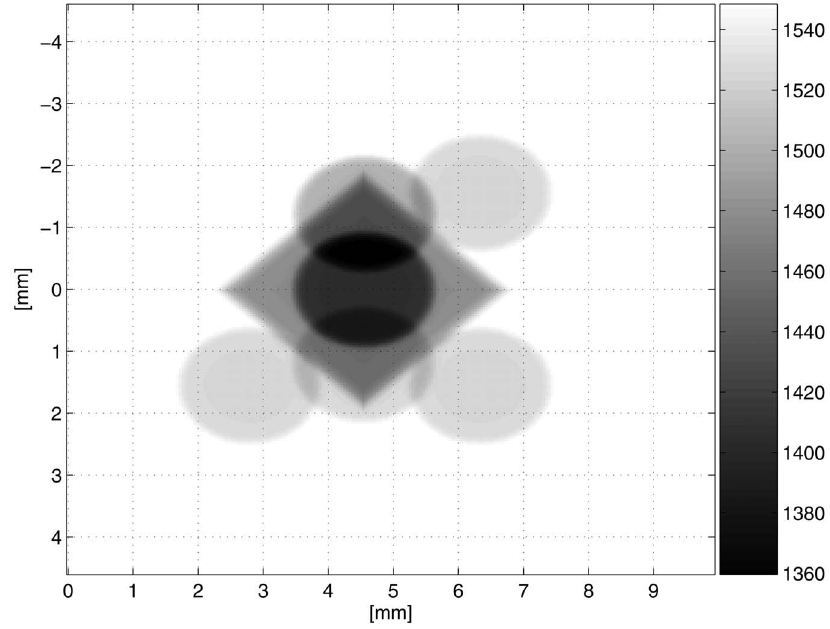
Figure 5. Sound speed variations used for the simulation